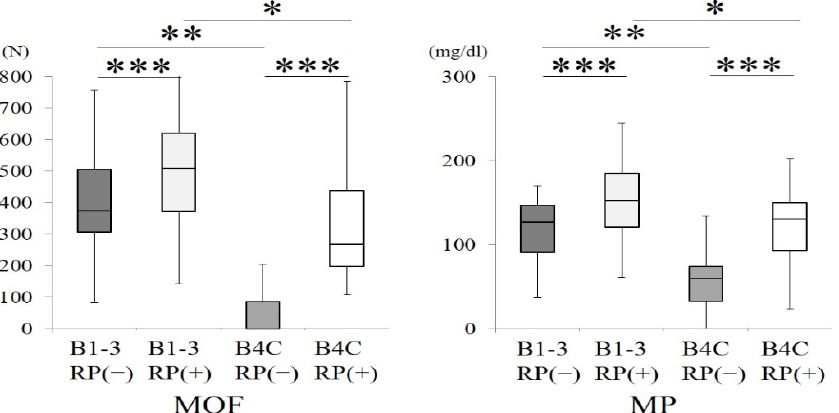
Figure 7. Comparisons of maximum occlusal force and masticatory performance between the B1–3 group and the B4C group with or without removable prostheses in each group (* p < 0.05, ** p < 0.01, Mann–Whitney U test). Comparisons of maximum occlusal force and masticatory performance between subjects with and without removable prostheses in each group (B1–3 group or B4C group) (*** p < 0.01, Wilcoxon signed-rank test). RP ( − ): subjects without removable prostheses; RP (+): subjects with removable prostheses.